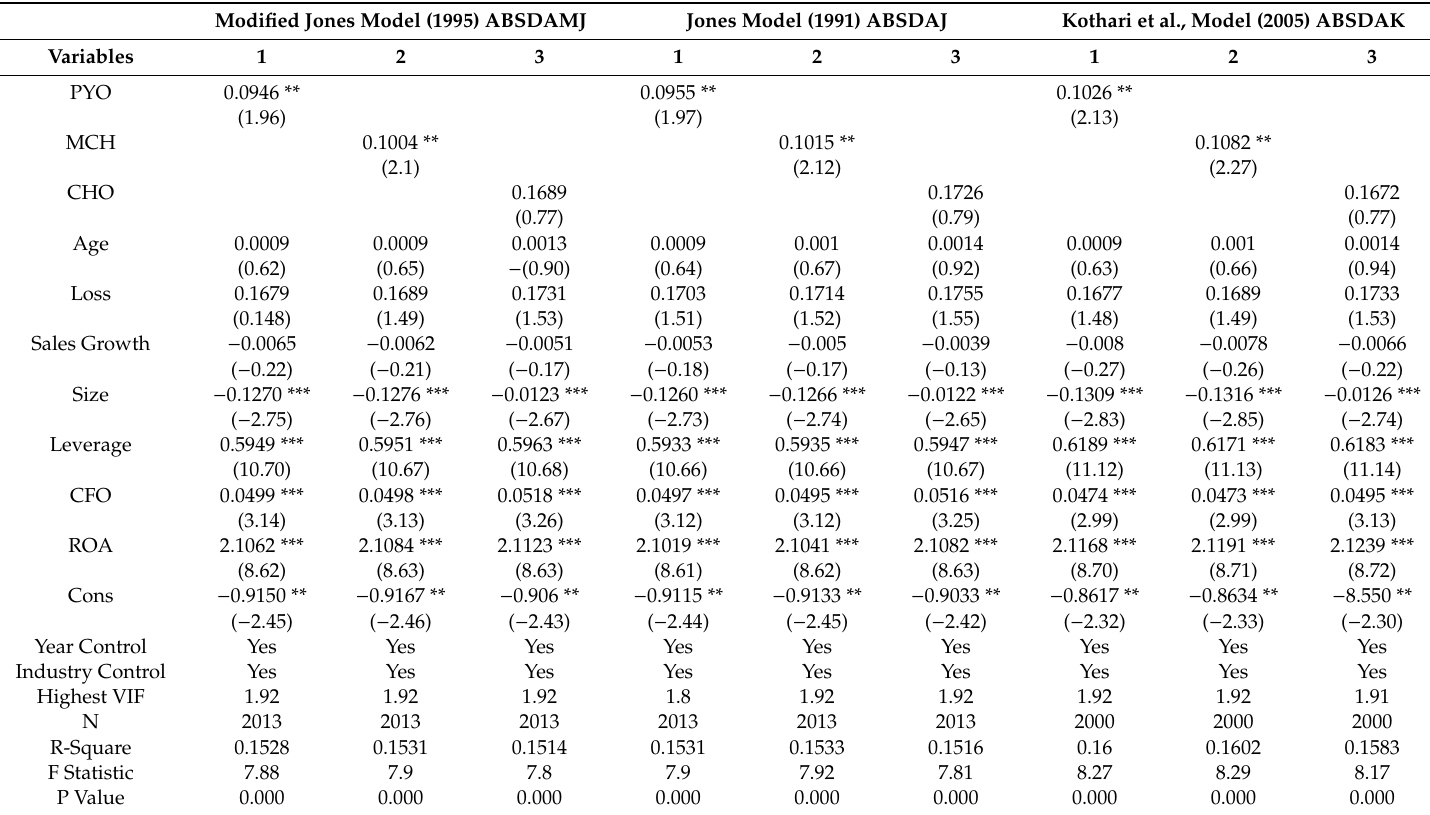
Table 5. Results for accruals earnings management models (modified Jones model 1995; Jones model 1991; Kothari et al. 2005). Modified Jones Model (1995)